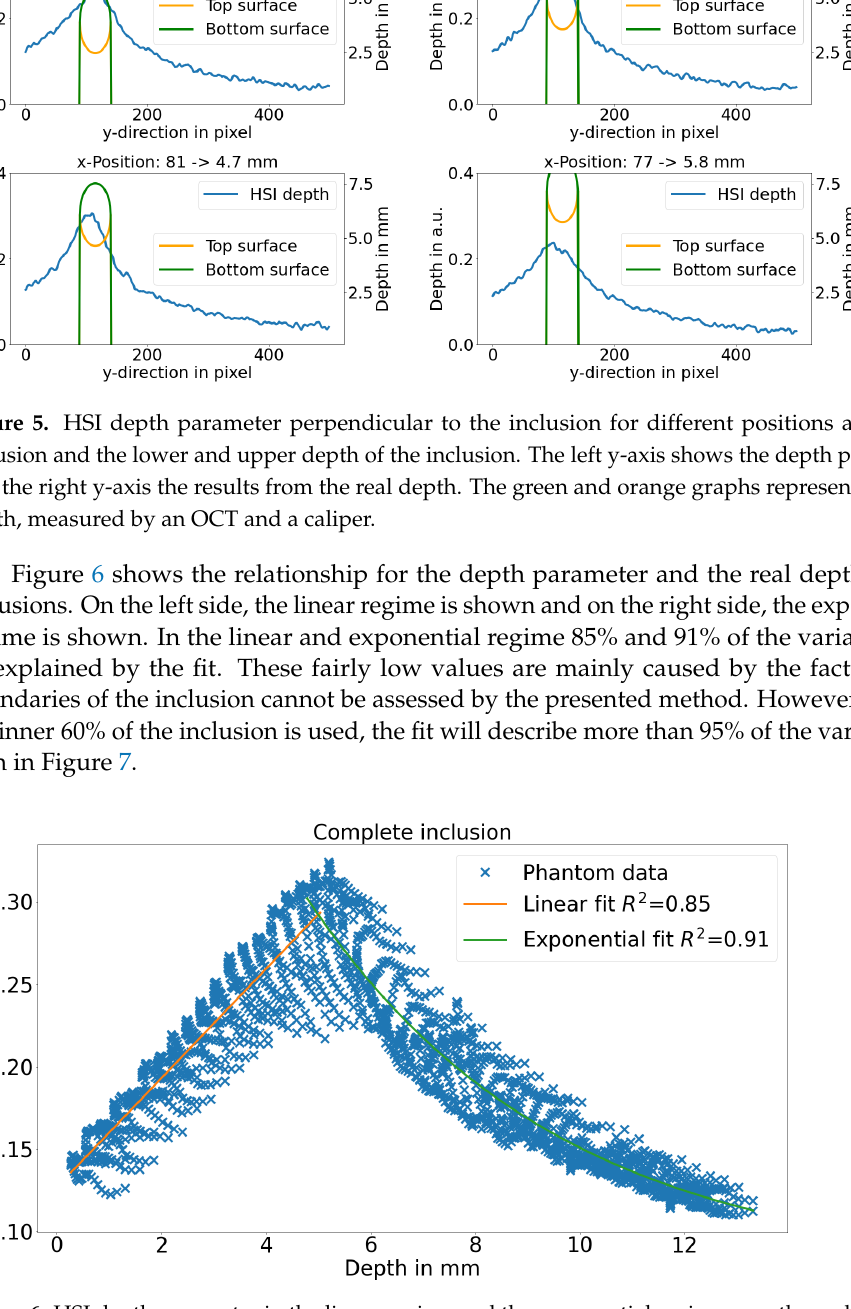
Figure 6. HSI depth parameter in the linear regime and the exponential regime over the real depth of the bottom channel with the according